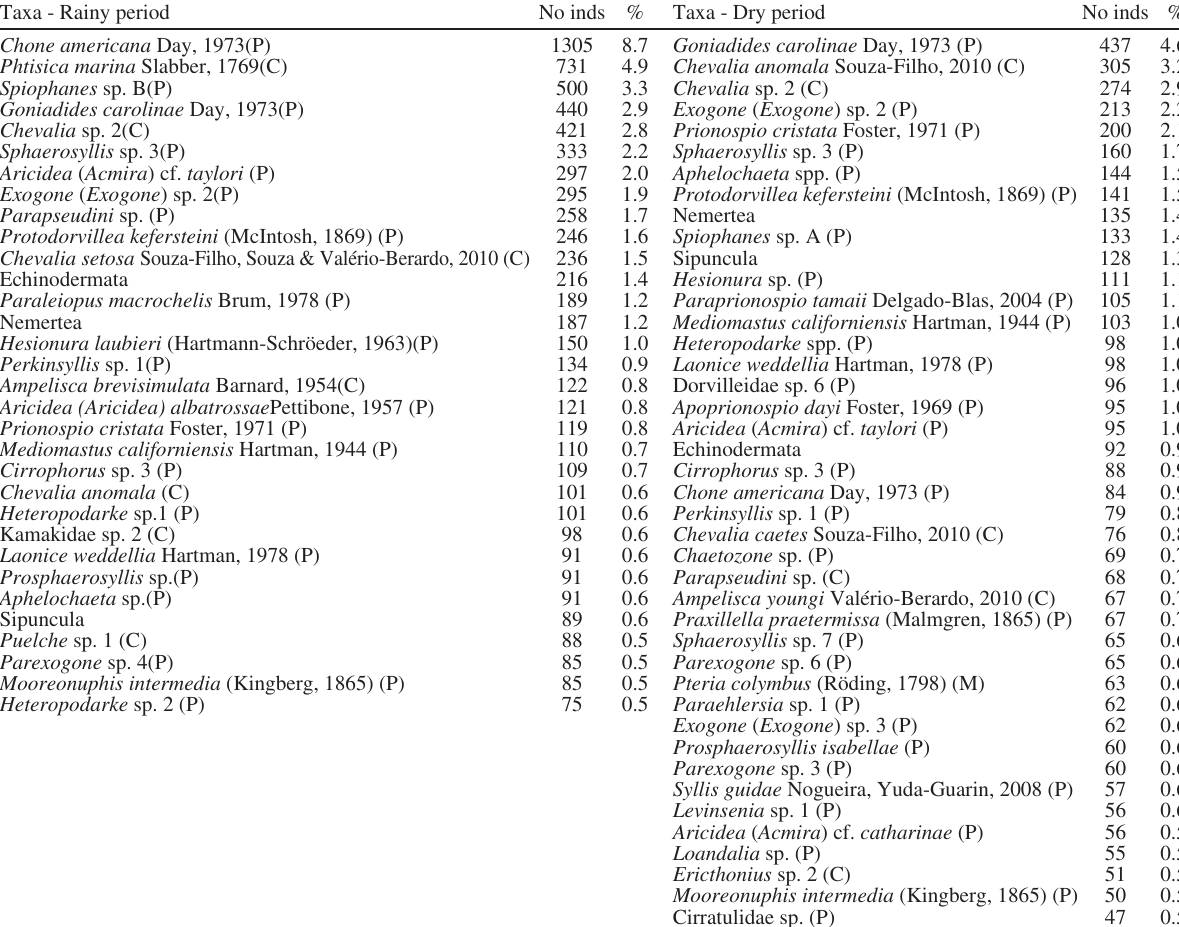
Table 1. – Total mean number of individuals per station and relative abundance of the most representative taxa (>0.5% abundance) during the rainy and dry periods of 2009 at 53 stations (P, Polychaeta; C, Crustacea; and M, Mollusca). Taxa - Rainy